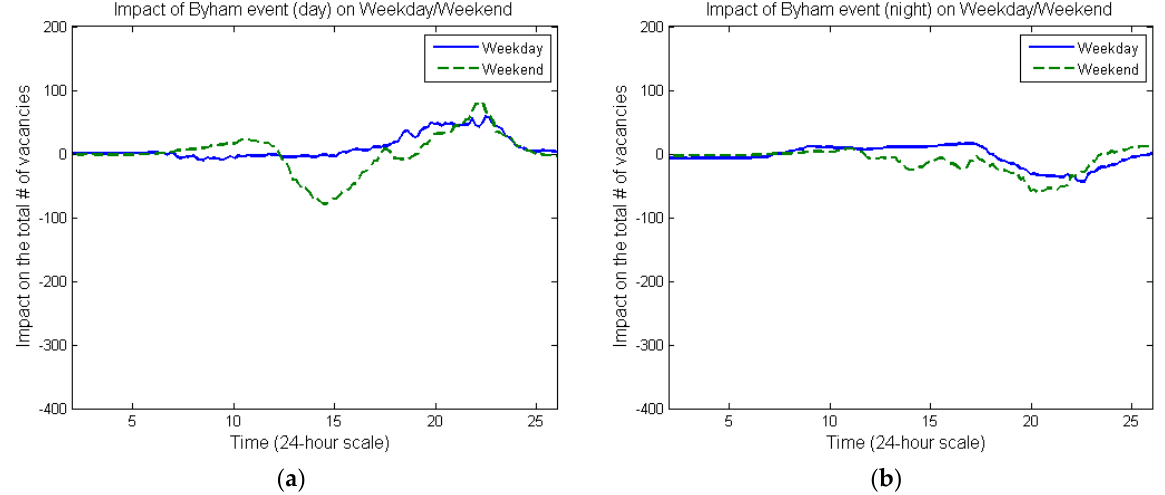
Figure 4. ( a ) Impact of Byham Theater event during daytime; ( b ) impact of Byham Theater event during nighttime.